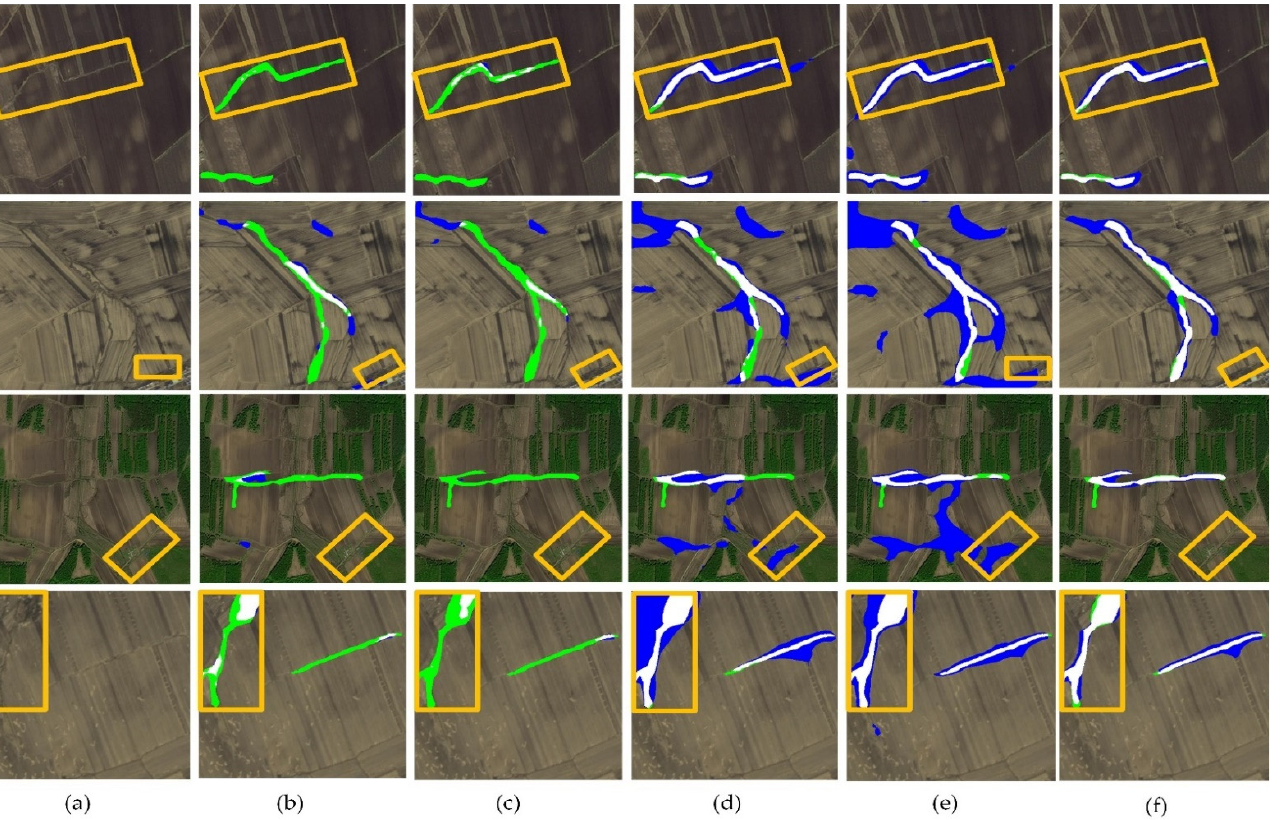
Figure 9. The latest monitoring data of Experiment 2 and corresponding labels. Among them, the colored rectangles are the representative lands, and the white as well as black pixels in the labels separately represent gully erosion and non-gully erosion.